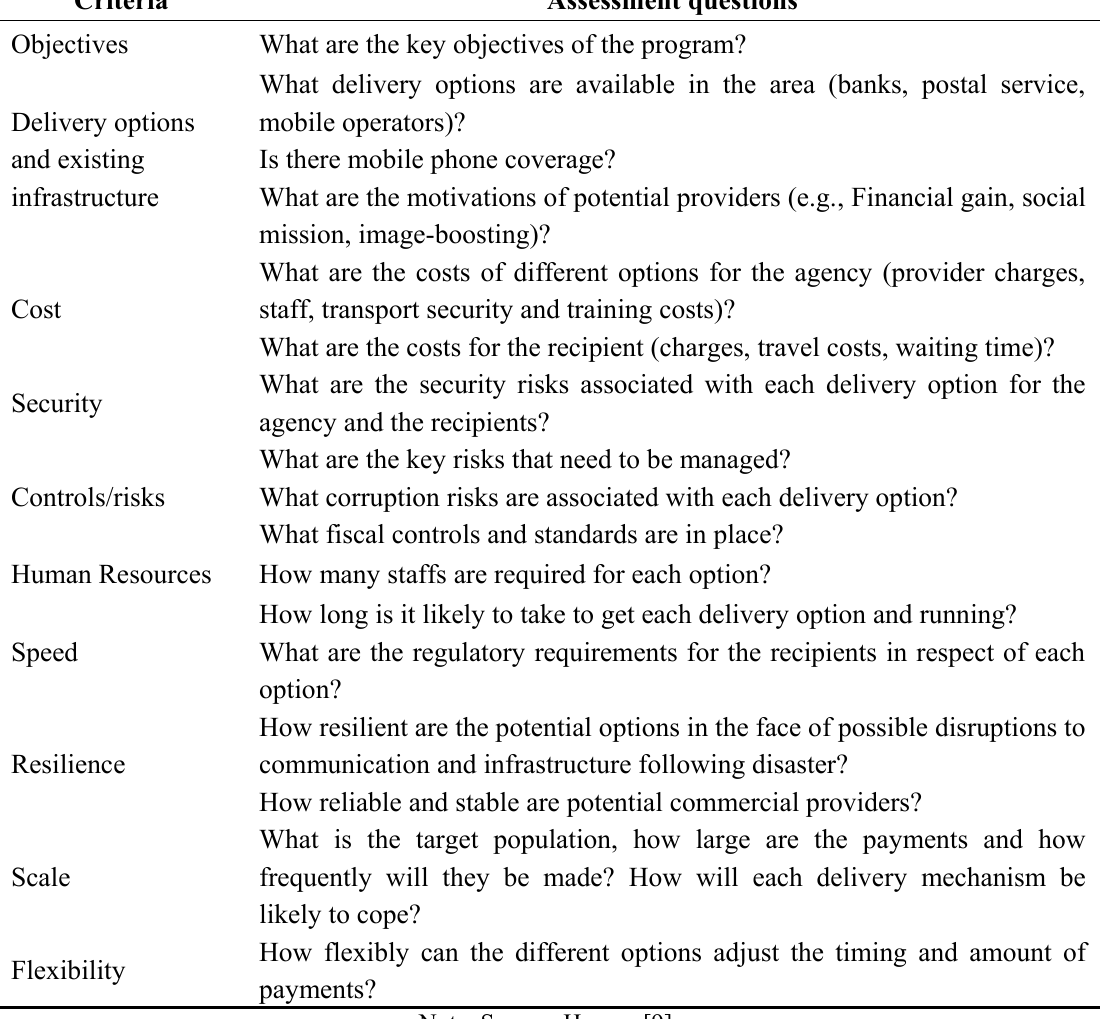
Table 2. Key criteria for assessing cash delivery